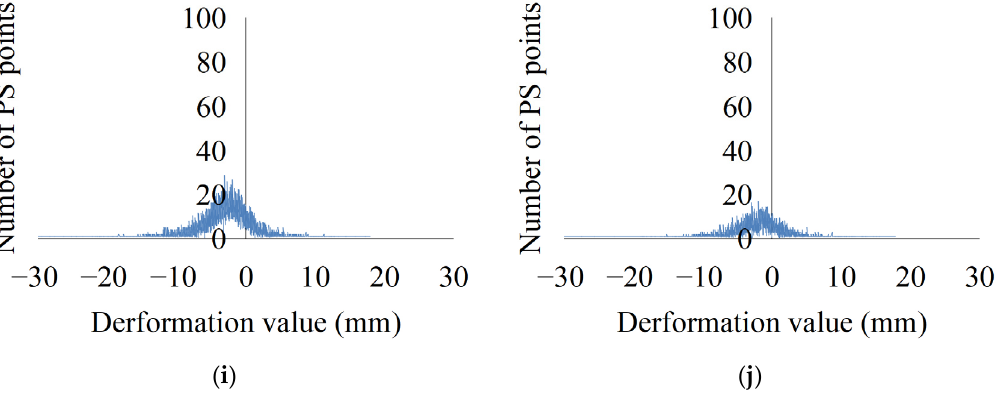
Figure 7. Statistics of the deformation values in the districts/cities in Qingdao. ( a ) Chengyang District; ( b ) Qingdao West Coast New Area; ( c ) Jiaozhou City; ( d ) Jimo District; ( e ) Laixi City; ( f ) Laoshan District; ( g ) Licang District; ( h ) Pingdu City; ( i ) Shibei District; and ( j ) Shinan District.